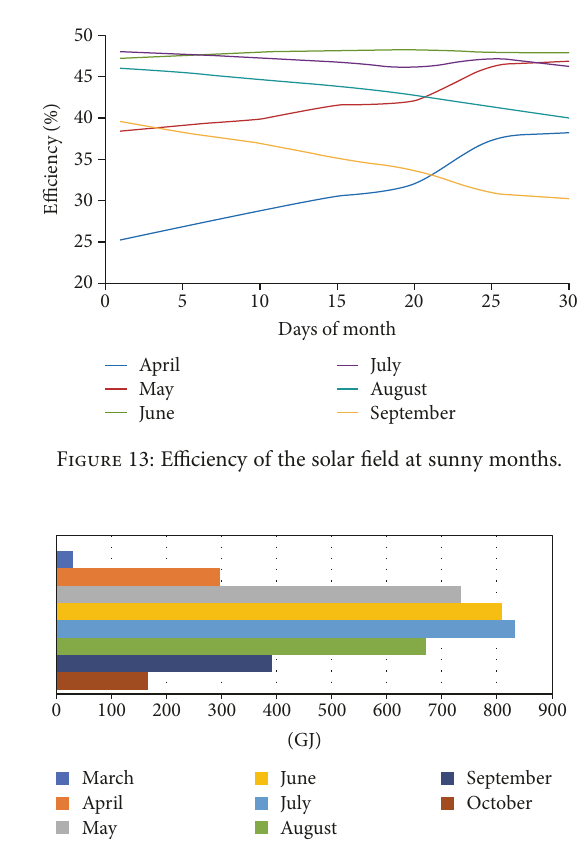
Figure 14: The provided thermal energy for the Rankine cycle without considering the storage system.